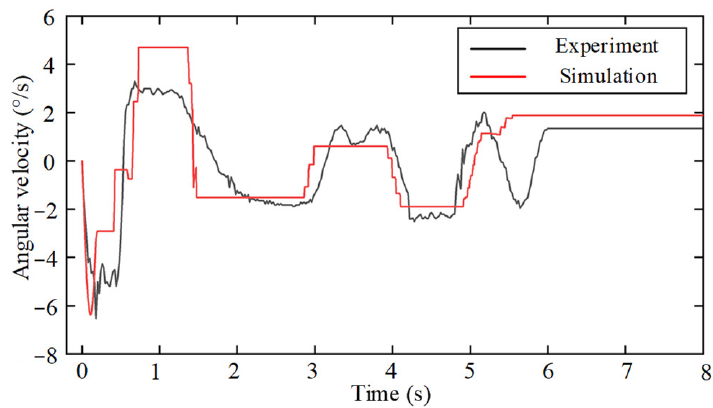
Figure 21. Angular velocity of the satellite under spring error.